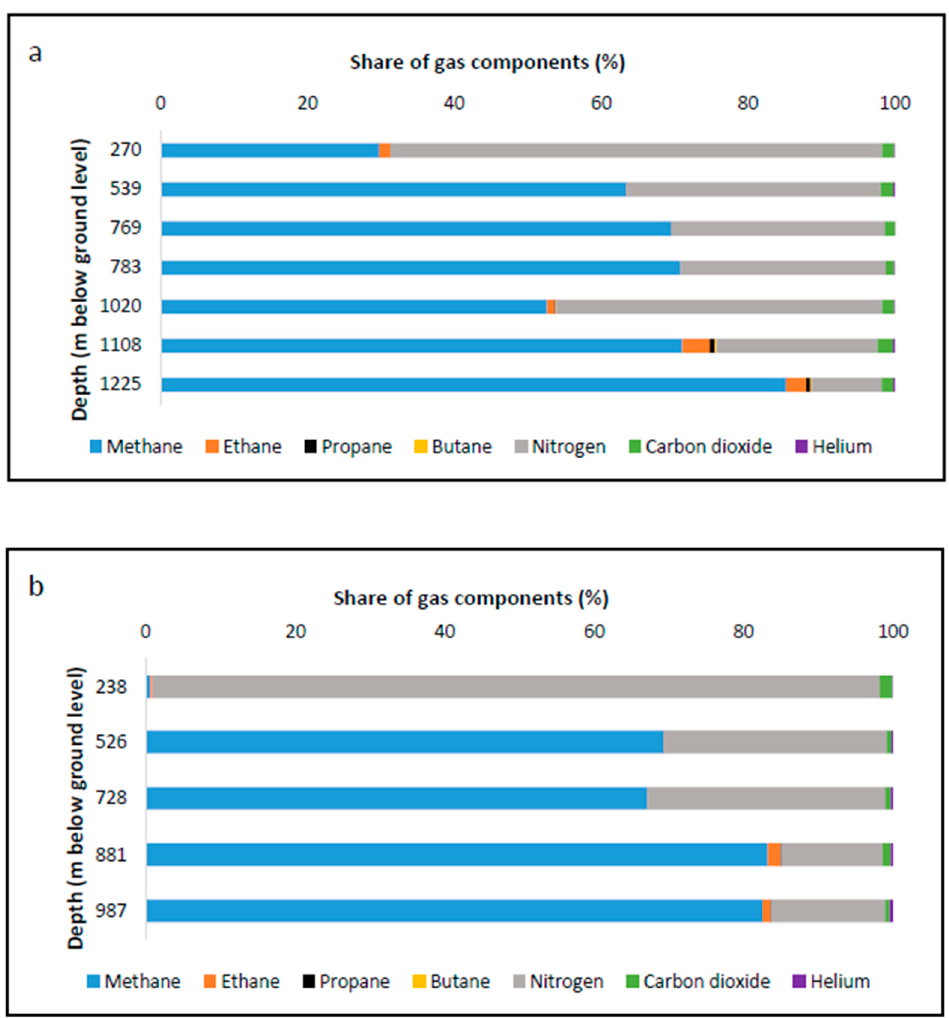
Figure 3. Gas composition versus depth in the study area, ( a )— Ć wikice sub-area, ( b )—Dankowice sub-area.